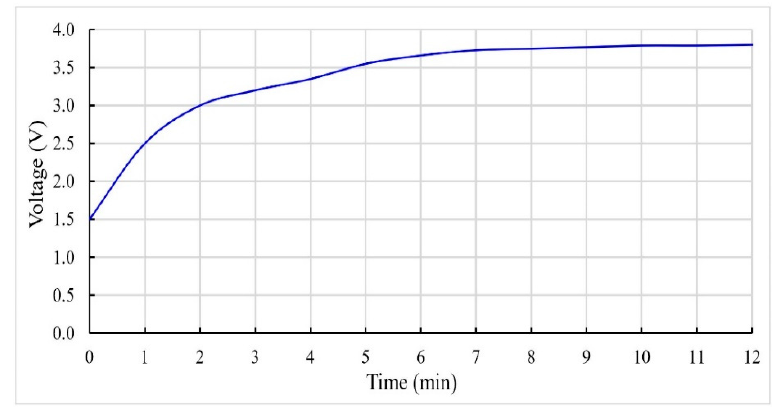
Figure 21. A typical charging curve wireless headphone battery.